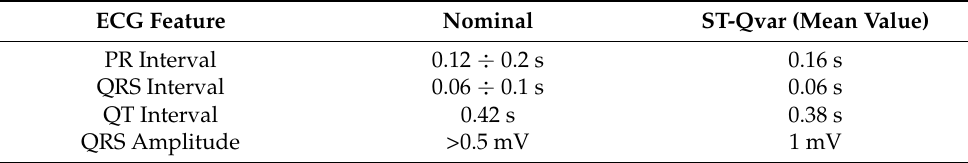
Table 1. ECG time intervals and amplitude ratio: nominal vs. ST-Qvar values.